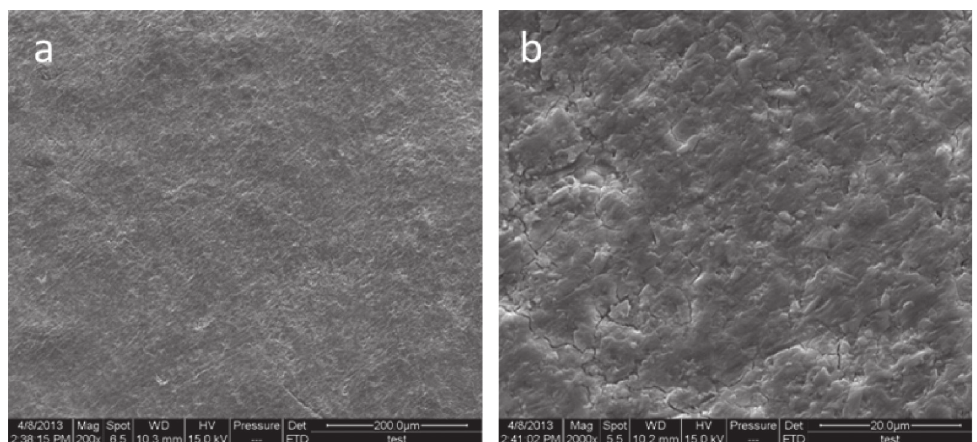
Figure 4: Surface morphologies of anodic oxidation coating.